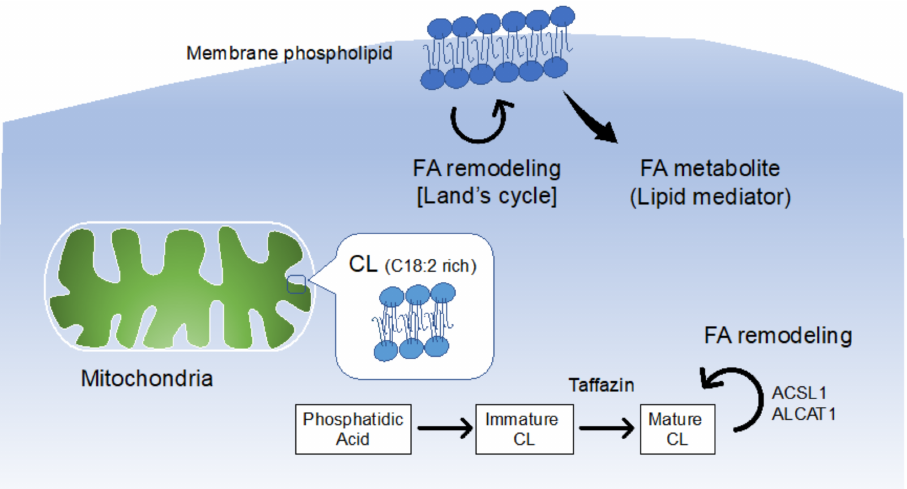
Figure 2. Intracellular dynamics of phospholipid-containing FAs. The diversity of the FAs is charac- terized by the action of various enzymes involved in the synthesis and remodeling processes. FA, fatty acid; CL,